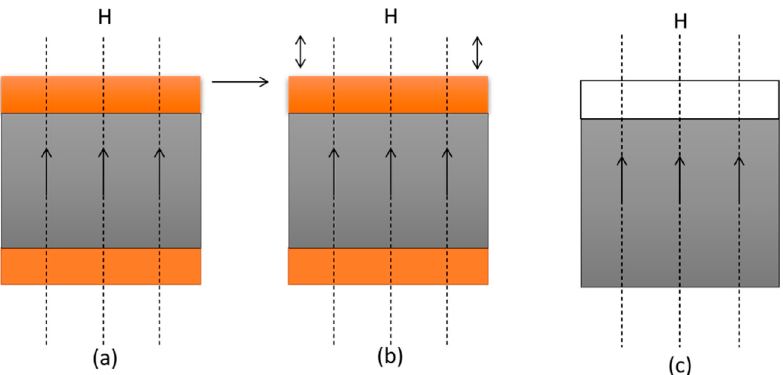
Figure 1. Representation of operational modes of MRE: ( a ) shear mode, ( b ) squeeze mode and ( c ) field-active mode.